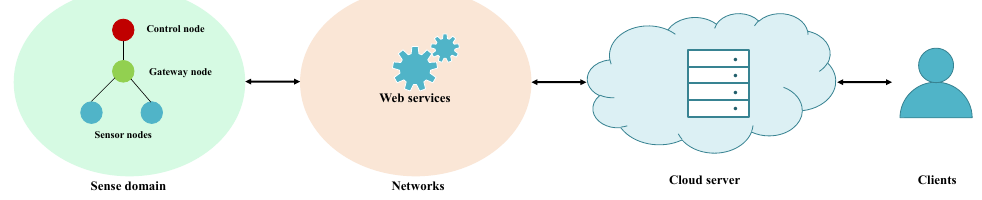
Figure 1. Energy-efficient architecture for the Industrial Internet of Things